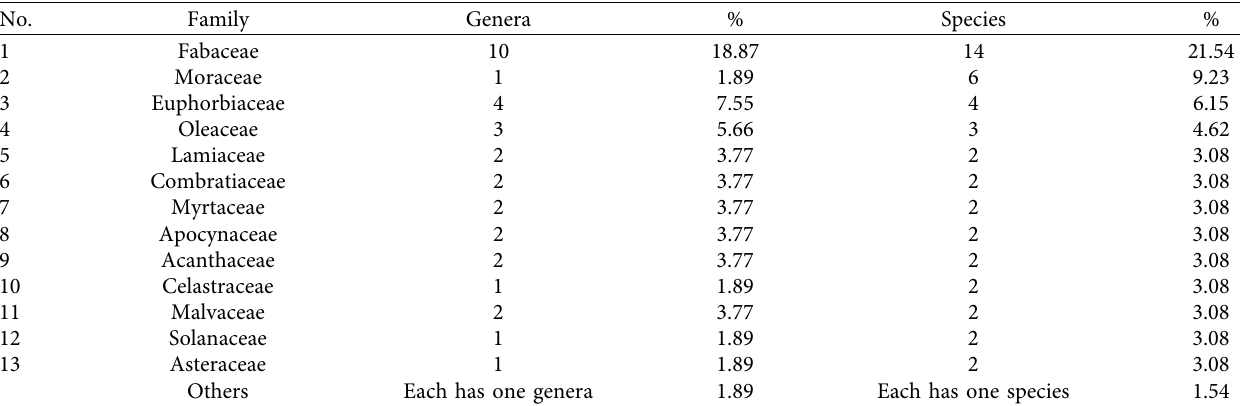
Figure 2: Distribution of woody plant species by their growth form in Wonjeta St Michael Church Forest. Table 1: Te top 13 families with their corresponding number of genera and species.